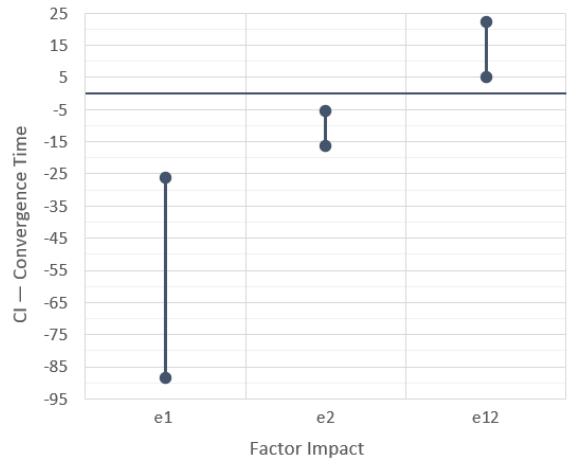
Figure 10. Di ff erences in convergence time when varying the number of robots with two di ff erent Figure 10. Differences in convergence time when varying the number of robots with two different control algorithms e 1 (average × circumcenter) and two fixed communication topologies e 2 (linear × control algorithms e1 (average x circumcenter) and two fixed communication topologies e2 (linear x grid), and its cross-factor relationship, with 99% confidence grid), and its cross-factor relationship, with 99% confidence intervals.